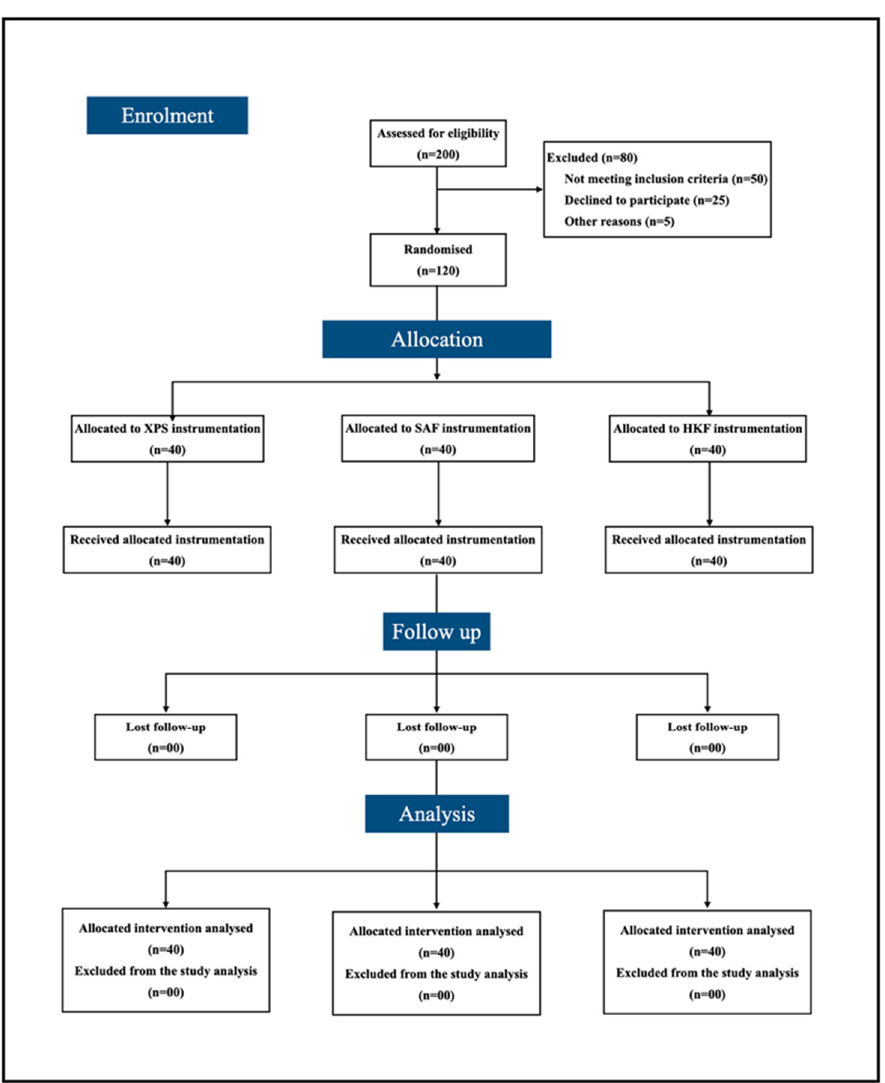
Figure 1. COSORT 2010